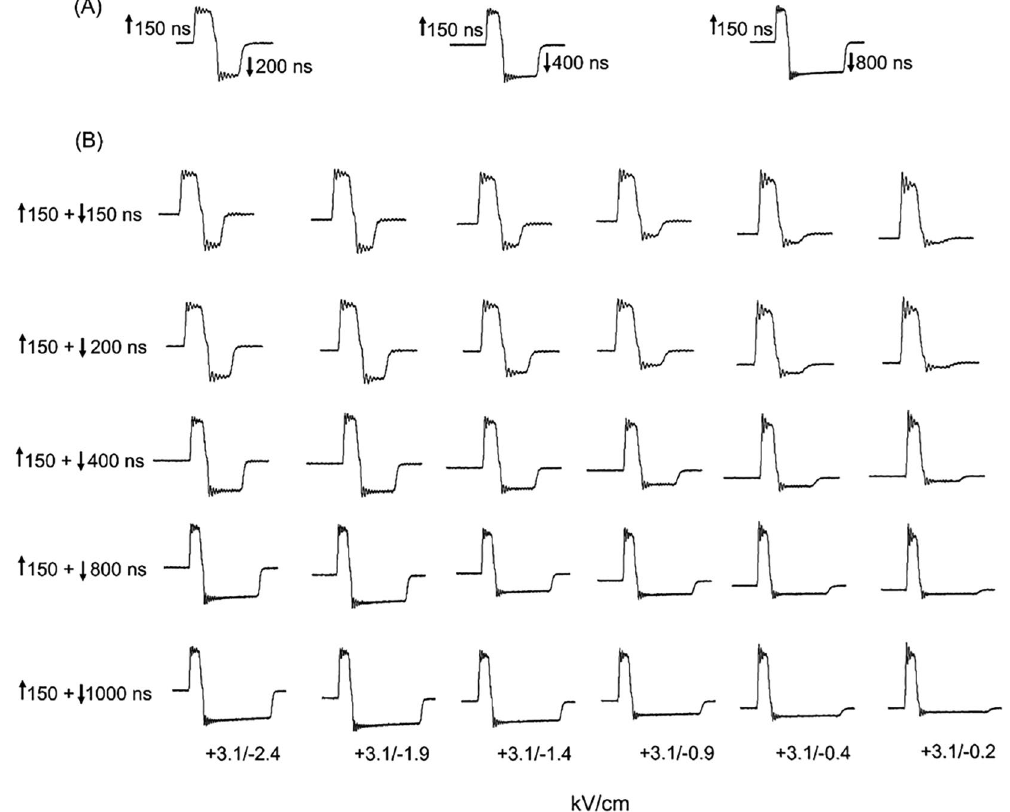
Figure 5. Representative oscilloscope traces of bipolar pulses having the same positive phase and negative phases but varying in duration and E-field magnitude. ( A ) Bipolar pulses in which the positive phase was 150 ns and negative phases were 200, 400 or 800 ns. In all cases, the E-field for each phase was set at 3.1 kV/cm. ( B ) Bipolar pulses in which the positive phase was 150 ns set at 3.1 kV/cm, and the negative pulse phase varied in amplitude from 2.4 kV/cm to 0.2 kV/cm (one E-field per column) and in duration from 150 to 1000 ns (one duration per